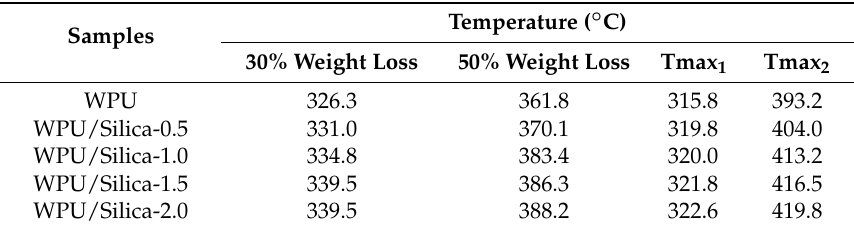
Table 2. TG data of WPU and WPU/Silica coatings.